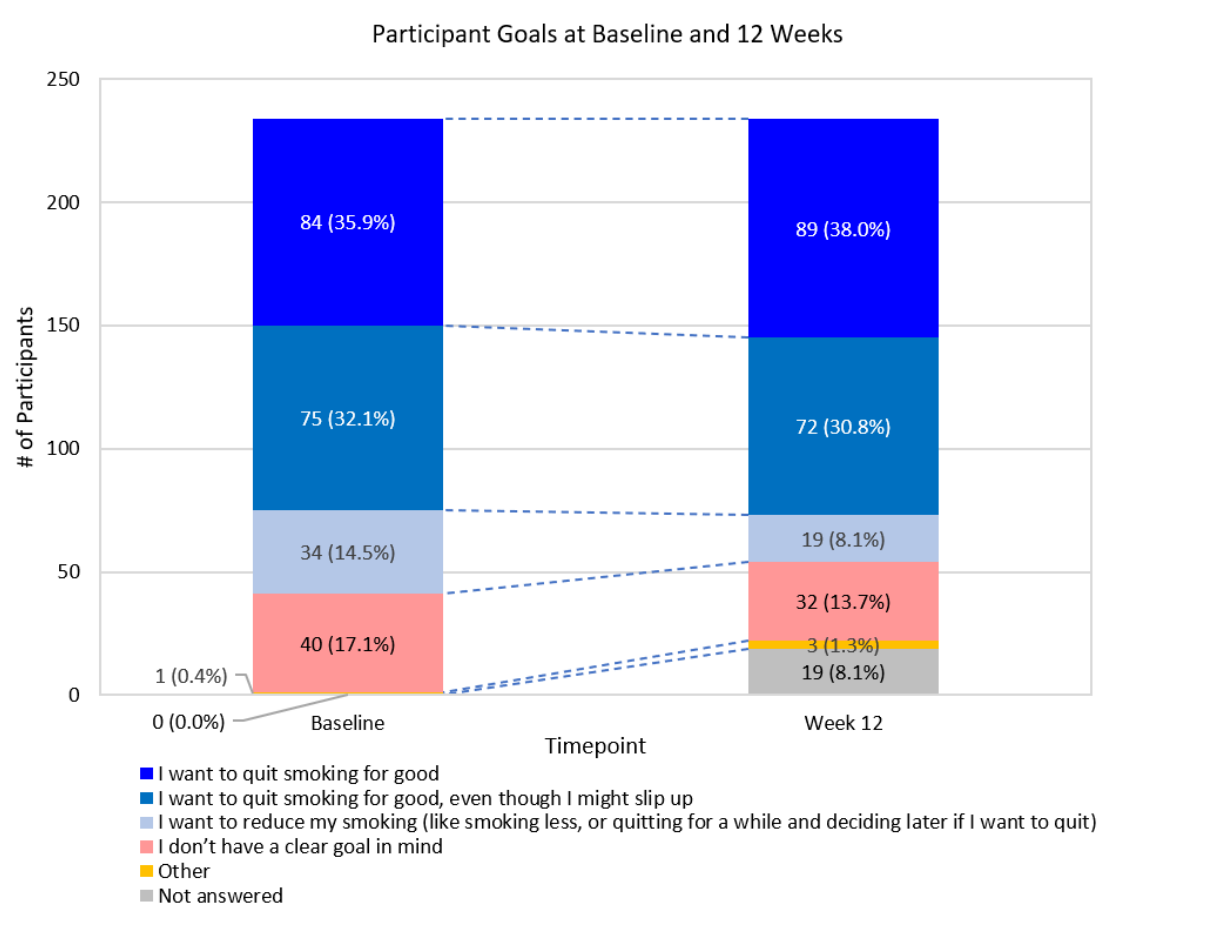
Figure 4. Participant goals at baseline and 12 weeks.